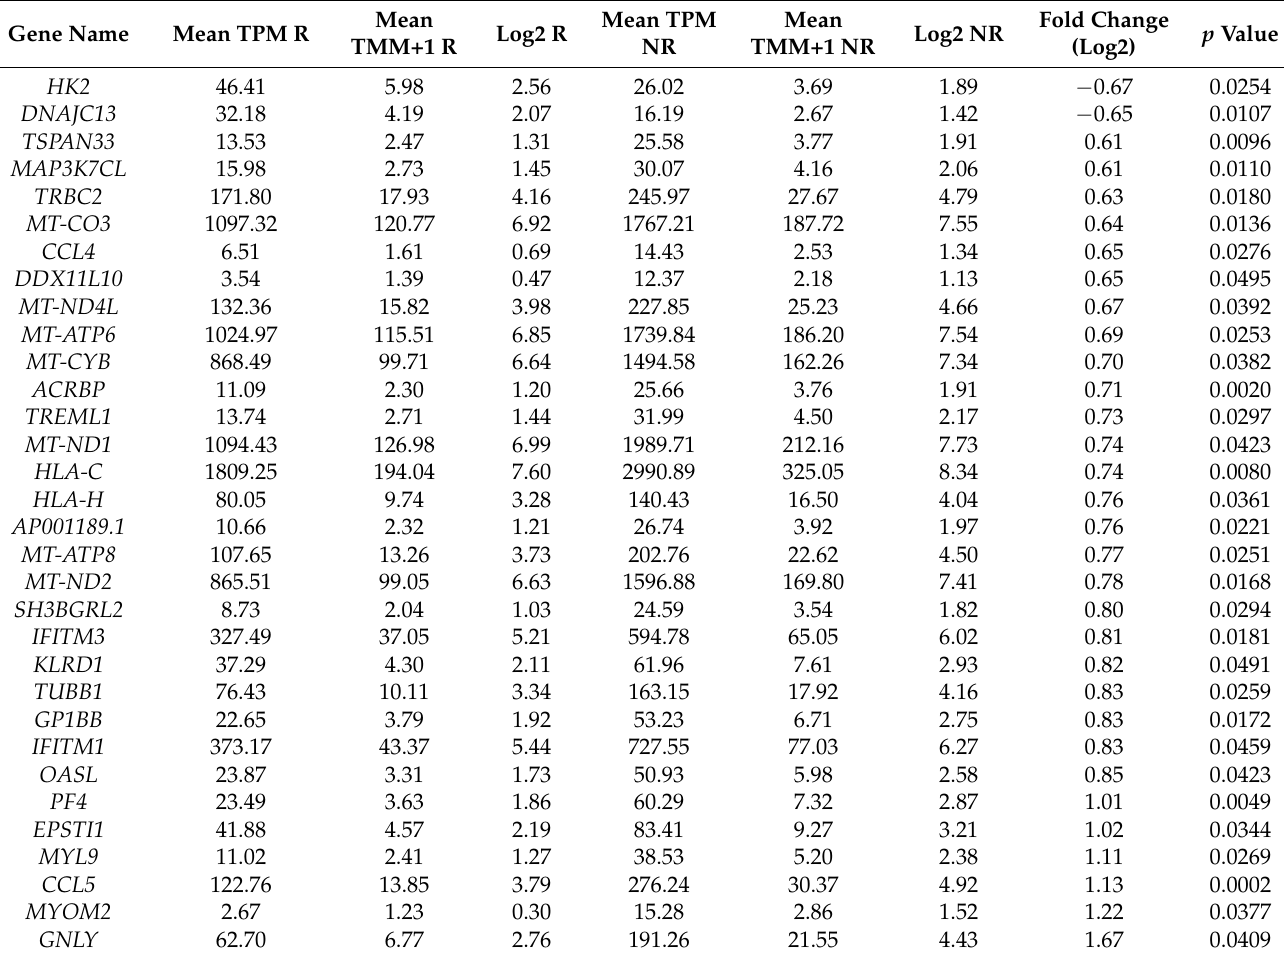
Table 3. List of genes expressed differentially between responders (R) and non-responders (NR) prior to initiation of anti-TNF